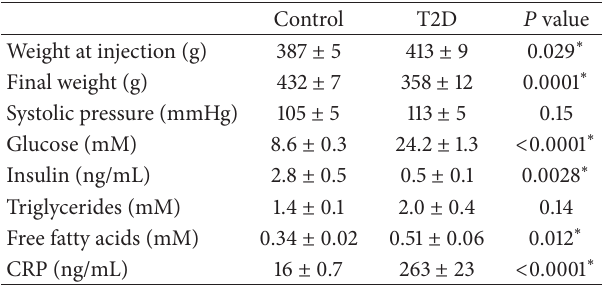
Table 1: Phenotype of control ( 𝑛 = 8 ) and T2D ( 𝑛 = 6 ) rats. Values are presented as mean ± standard error of the mean. ∗ indicates 𝑃 < 0.05 between T2D and control.